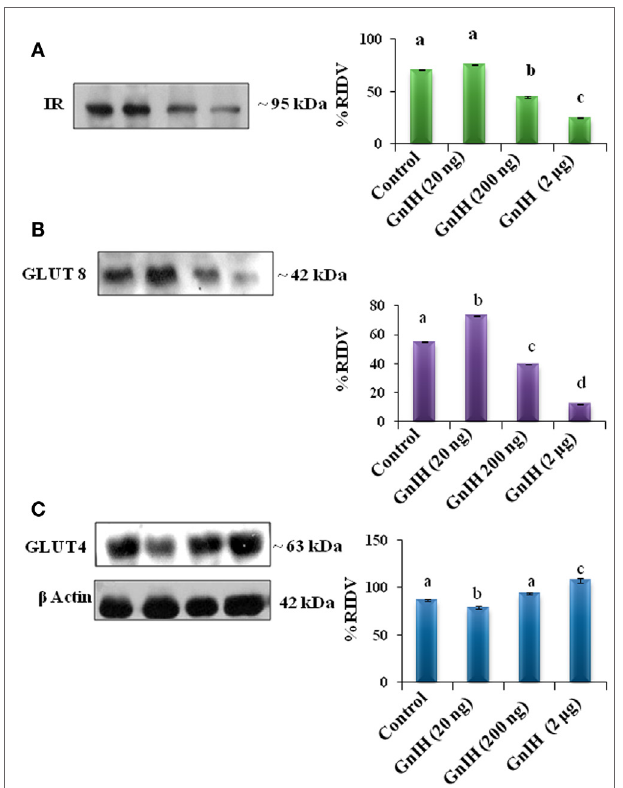
FigUre 2 | The densitometric analysis of the Western blot showed the treatment of different doses (20, 200 ng, and 2 μ g/day) of gnih on expression of ir, glUT8, and glUT4 proteins in adipose tissue of mice. (a) GnIH showed a dose-dependent significant ( p < 0.05) decline in the expression of IR. Moderate and high doses of GnIH (200 ng and 2 μ g/ day) showed significant (b and c, p < 0.05) decrease in the expression of IR protein as compare with control (a, p < 0.05). (B) A low dose of GnIH (20 ng/ day) showed significant (b, p < 0.05) increased in the expression of GLUT8 protein as compared to the control. However, moderate and high doses of GnIH (200 ng and 2 μ g/day) showed significant (c and d, p < 0.05) decrease in the expression of GLUT8 protein as compare with control (a, p < 0.05). (c) A low dose (20 ng/day) of GnIH treatment showed significant ( p < 0.05) decrease in the expression of GLUT4 whereas a high dose (2 μ g/day) showed significant ( p < 0.05) increase in the expression of GLUT4 as compared with the control in the adipose tissue. Values are mean ±